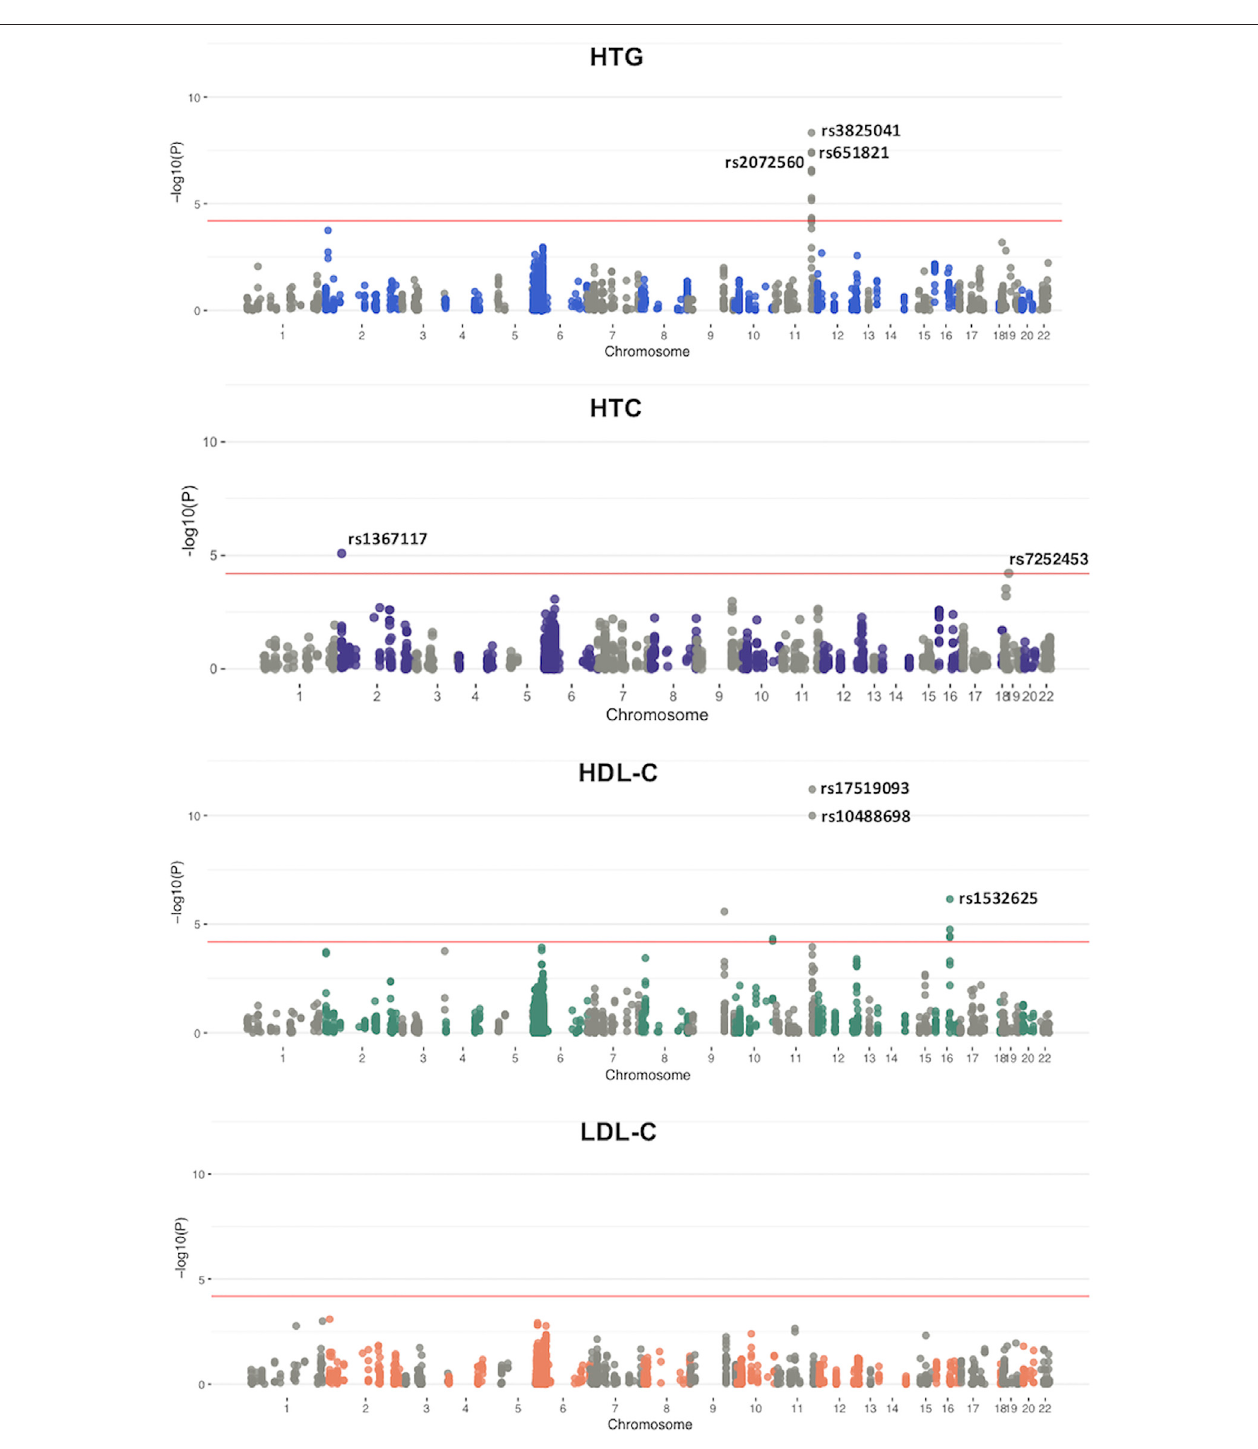
FIGURE 2 | Manhattan plots from a meta-analysis based on the genome-wide association analysis. Panels show the − log p value for SNVs for each lipemic traits. Top hits for each trait are indicated in the fi gure. Red line indicates the signi fi cant threshold line: p = 6.4 × 10 − 5 .